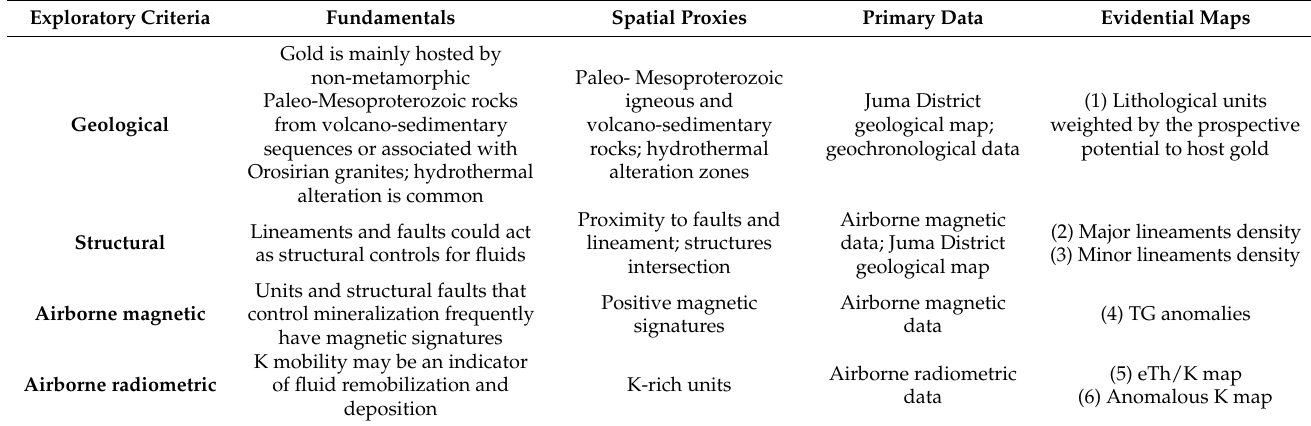
Table 2. Key characteristics describing the theoretical fundamentals, spatial proxies, primary data, and evidential maps using different exploratory criteria for the Juma